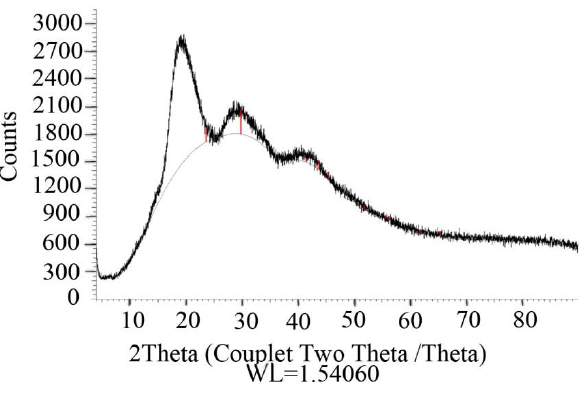
Figure 1 . Example of a typical diffractogram of Se/AG NC based on the X-ray phase analysis